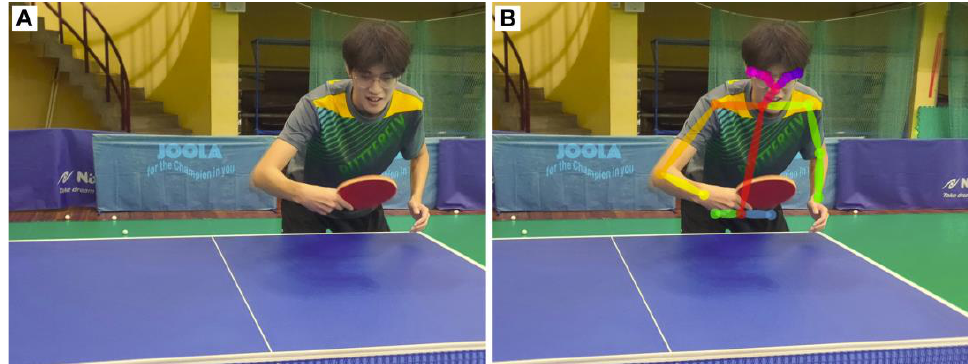
Figure 11. ( A ) Original photo. ( B ) Photo after AI analysis. The original photo and photo after AI analysis.